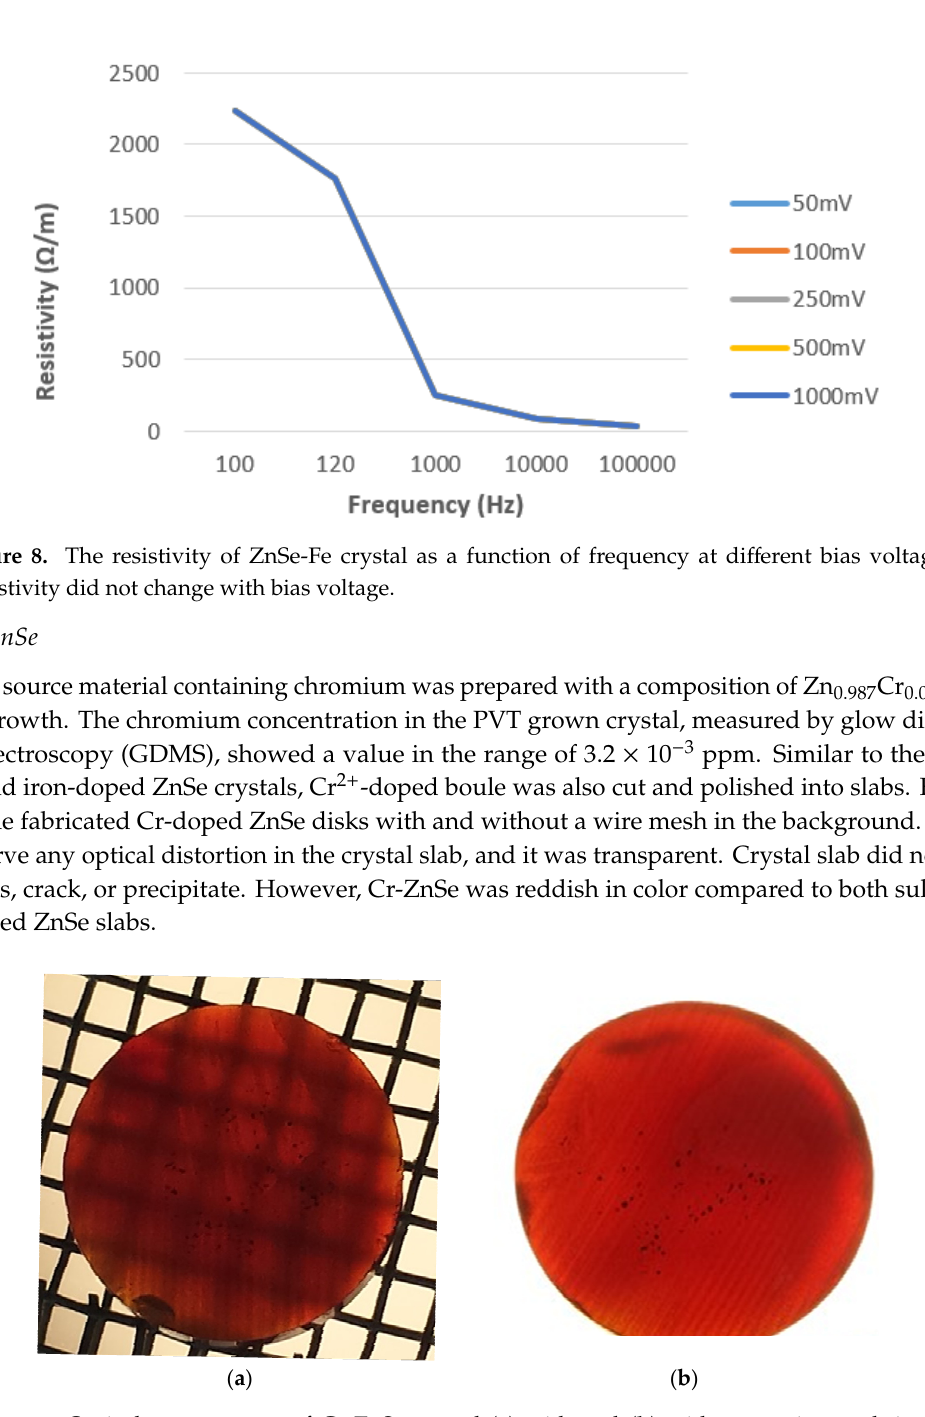
Figure 9. Optical transparency of Cr ‐ ZnSe crystal ( a ) with and ( b ) without a wire mesh in the background. Slab did not show voids, bubbles, and optical distortion.